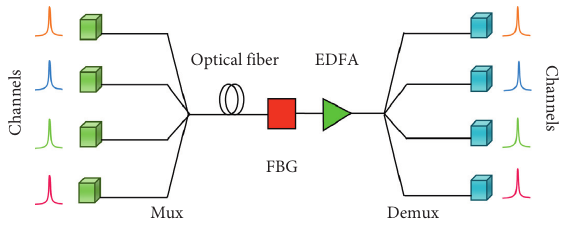
Figure 1: Optical transmission system